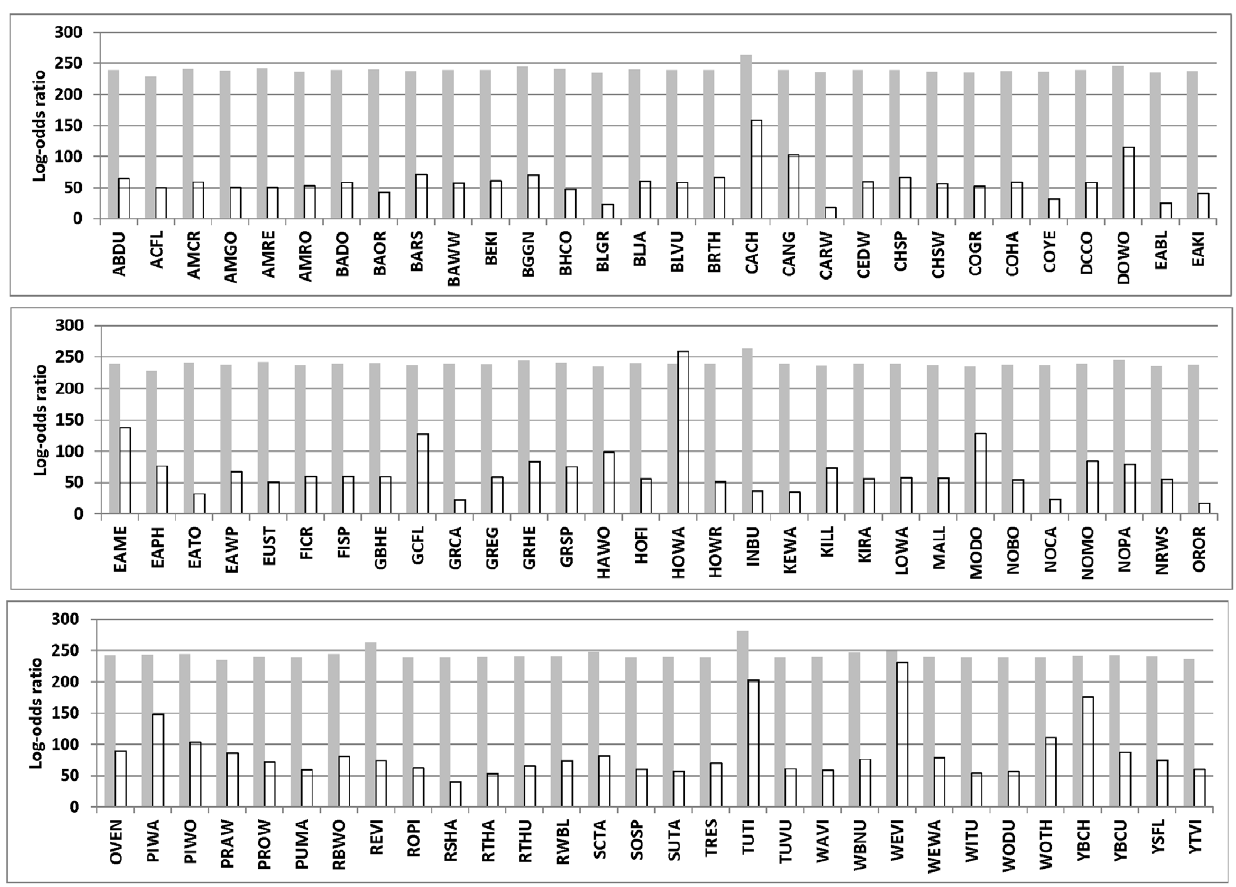
Figure 3. Strength of autocorrelation for individual species across the bird community at Patuxent National Wildlife Refuge. Gray bars represent a reduced model with only spatial effects included; unfilled bars represent a global model with landcover and spatial effects included. Bar heights represent means from the posterior distribution of a Bayesian analysis based on three independent MCMC chains (n=20,000). All of the Bayesian credibility intervals overlapped and are not shown for clarity.